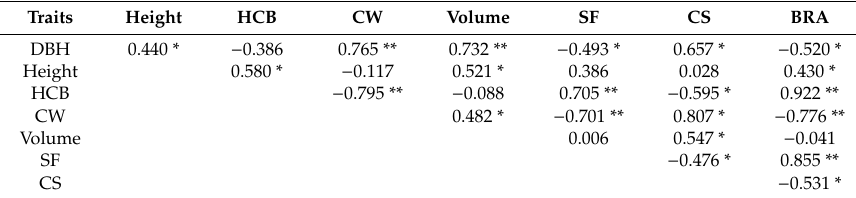
Table 7. Genotypic correlation coe ffi cients among tested